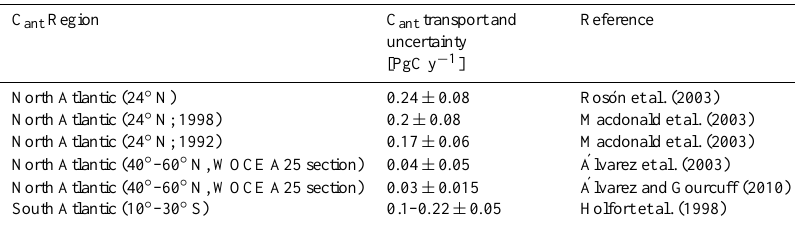
Table A4. Published estimates of C ant transport and its uncertainty for different regions.